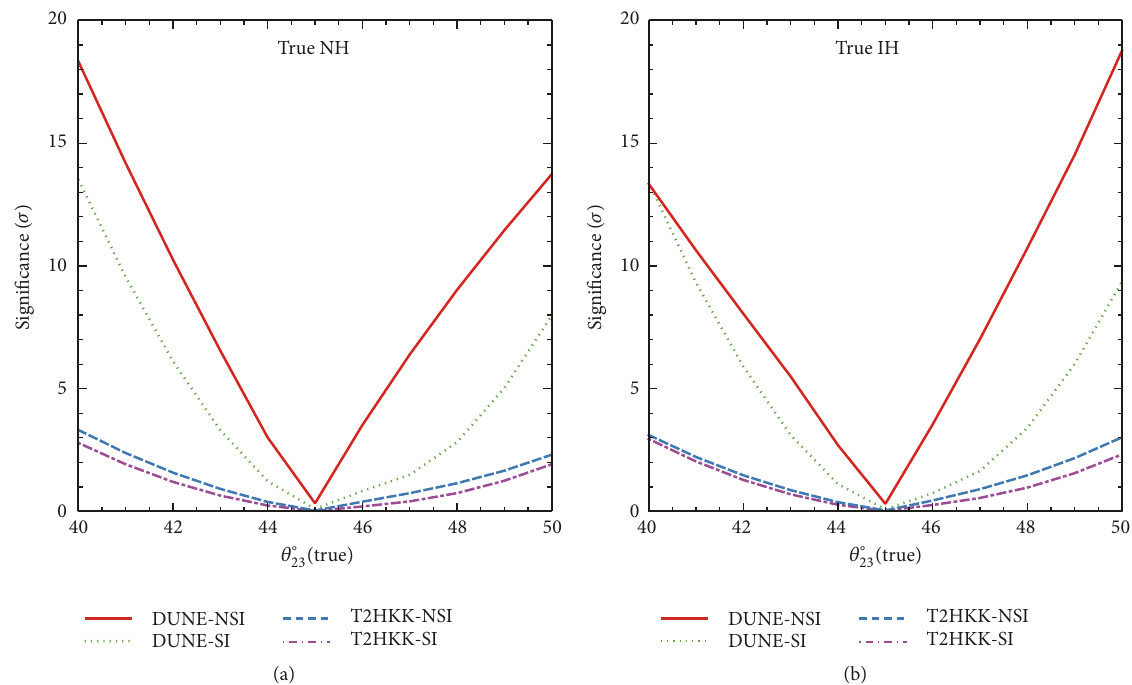
Figure 5: Sensitivity plots for 𝜃 23 octant with true NH (left) and true IH (right), assuming NSI parameters 𝜖 푒휇 = 0.04 and 𝛿 푒휇 = [−𝜋,𝜋] .